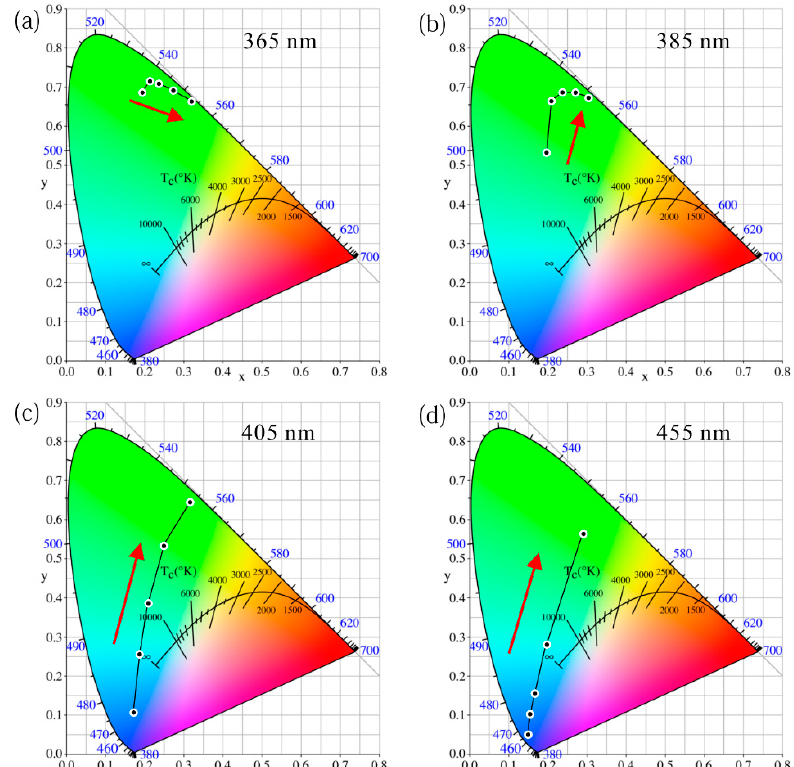
Figure 8. Chromaticity diagram of GQD LED with different QD concentrations under ( a ) 365 nm, ( b ) 385 nm, ( c ) 405 nm, and ( d ) 455 nm of excitation.